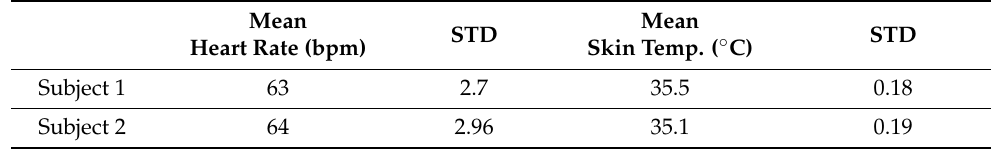
Table 2. Mean of calculated heartrate and skin temperature for subjects.